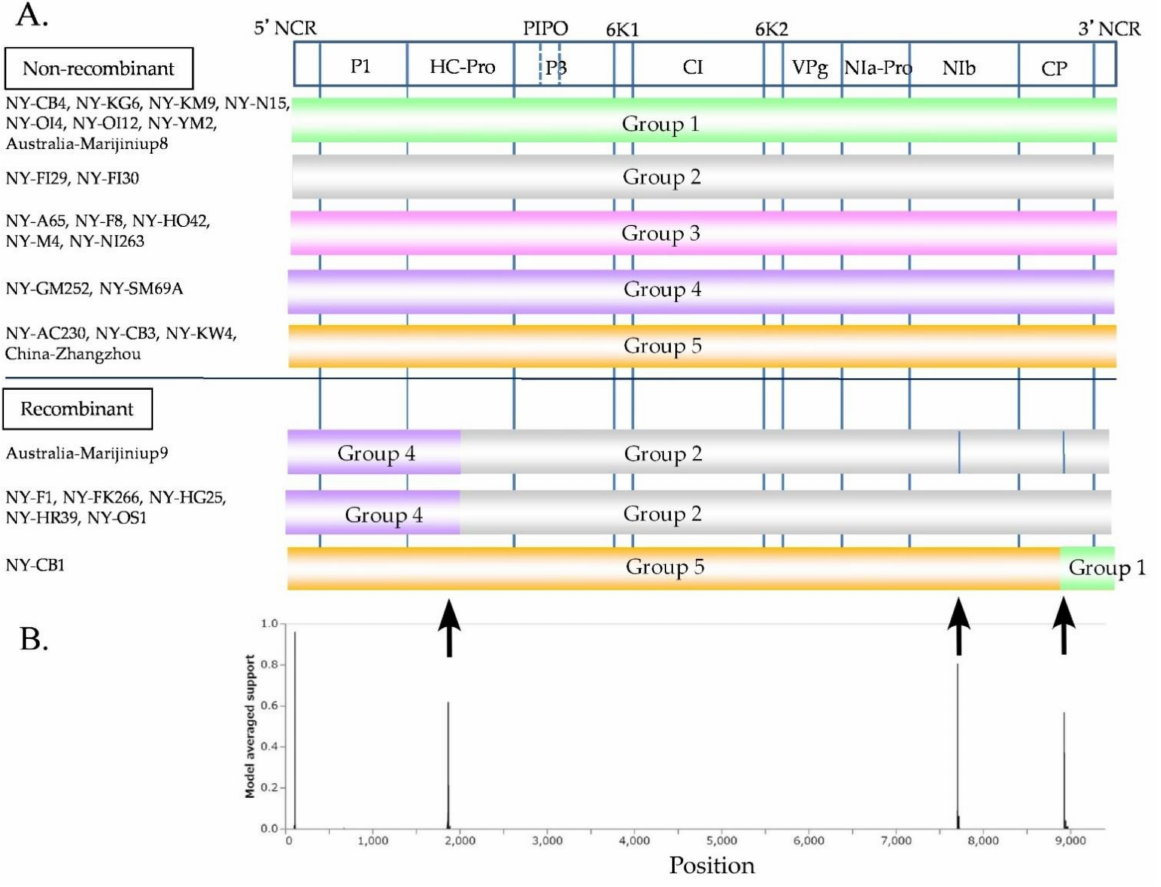
Figure 3. Recombination analysis. ( A ) Recombination genome map of the narcissus late season yellows virus (NLSYV) genomes of each isolate. Vertical solid lines show estimated approximate recombination sites. ( B ) The best placement of recombination sites (breakpoints) inferred by the algorithm for each site considered by GARD. The nucleotide positions correspond to the genome of the Zhangzhou isolate [26]. Note that recombination site around nt 9000 in Marijiniup9 genome is